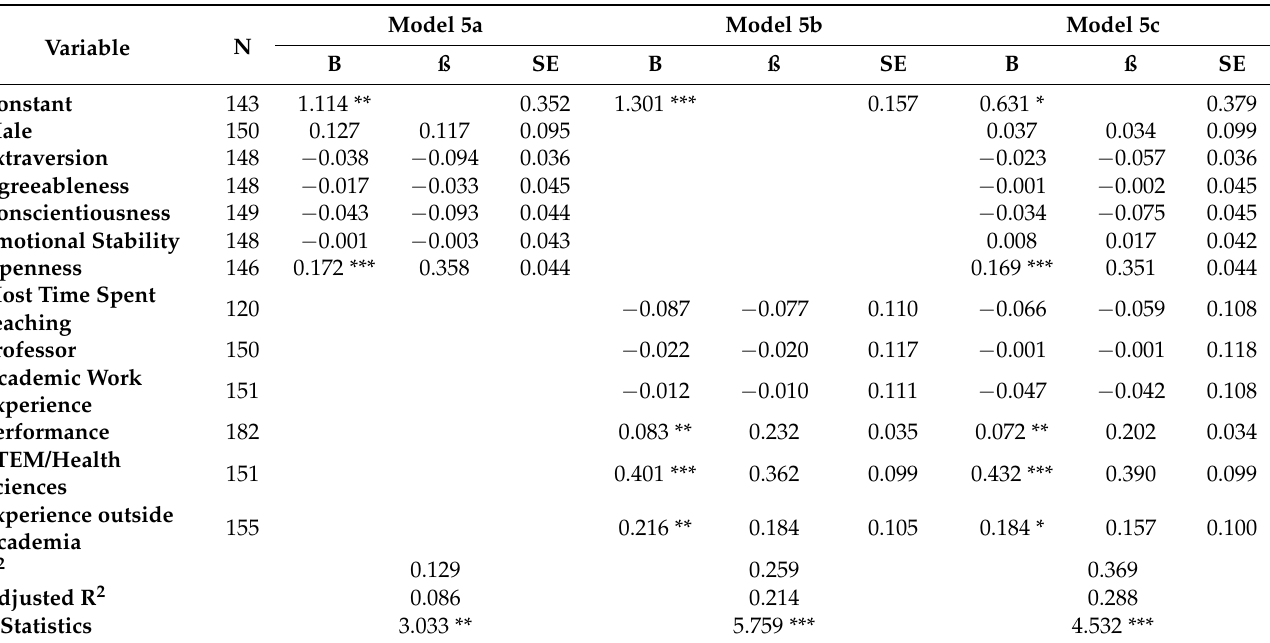
Table A5. Multiple regression models for predicting engagement in commercialisation